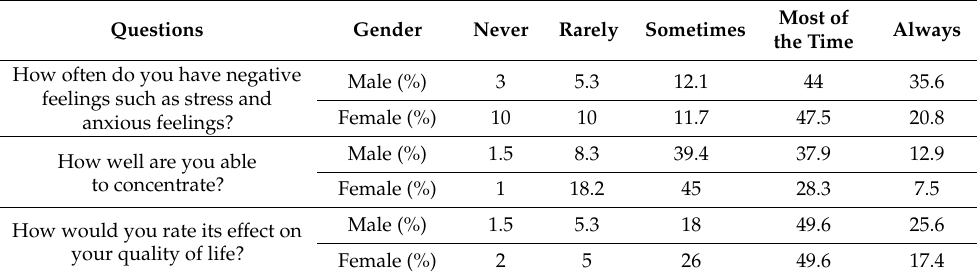
Table 3. Negative consequences of Neck